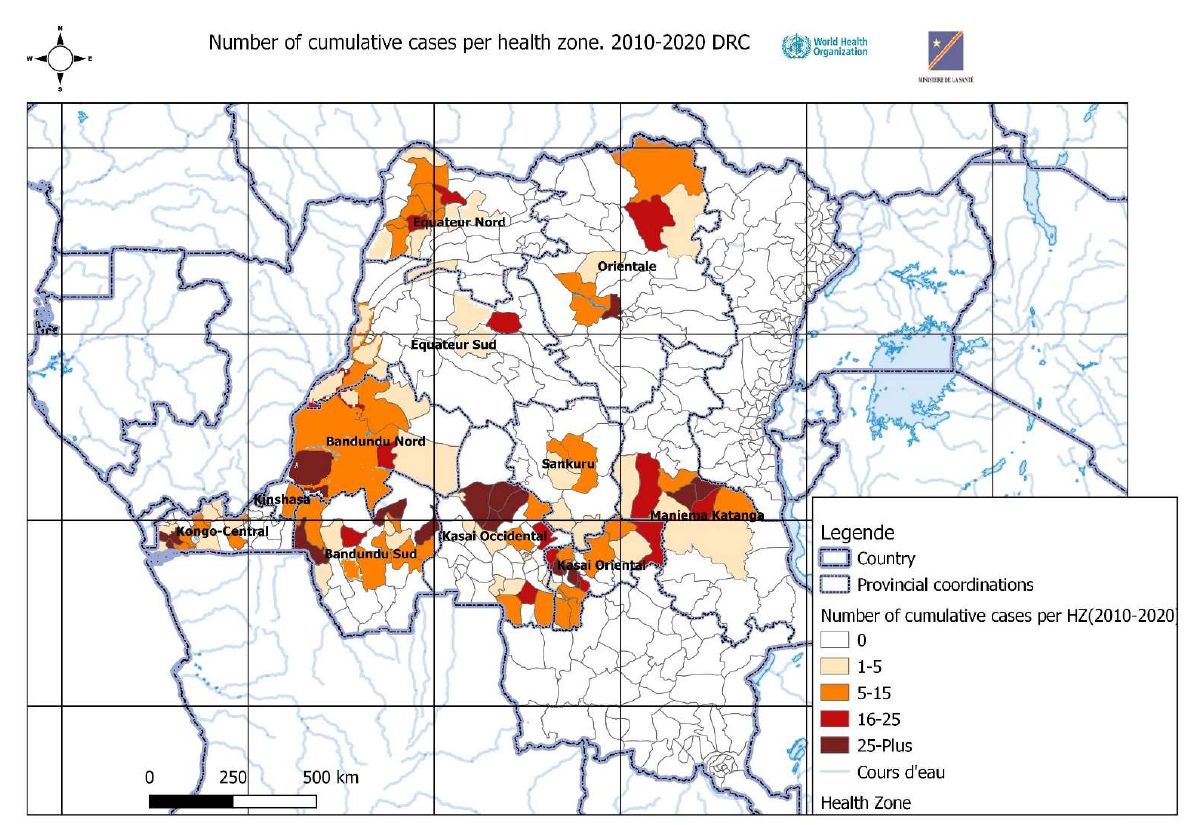
Figure 1. Map of HAT prevalence in the Democratic Republic of Congo. (Source = PNLTHA DRC). HAT control includes three key strategies: screening of people living in endemic areas, treatment of infected people to eliminate the human reservoir, and the reduction of human–tsetse fly contact through vector control activities [4,5]. Screening for HAT is done actively or passively. Active screening includes mass campaigns organized by mobile teams aimed at all people living in targeted endemic areas. Passive screening happens at health centers or hospitals when infected people seek health care. Treatment of HAT is offered free of charge to those who have been infected [6,7]. 1.2. Local Communities’ Knowledge of and Behaviors towards HAT In DRC, local communities living in endemic areas have a good understanding of HAT, including the vector and the symptoms (especially for the second phase). They also have good information about control measures: diagnosis, treatment, and vector control [8]. In DRC, most community members in endemic areas are knowledgeable about screening processes, especially lumbar puncture and its side effects [8]. When it comes to treatment, people living in endemic areas know that sleeping sickness can only be treated by specialized health workers [8]. People from the community can tell the difference between Arsobal (the old treatment) and NECT (the newer treatment) [9]. In relation to vector control, local communities are familiar with the main strategies: tsetse traps and clearing their surroundings, which contribute to reducing tsetse fly–human contact [10]. This local community knowledge of HAT has also been found in studies conducted in other endemic countries such as South Sudan [11], Uganda, and Kenya [12]. However, in DRC, as in other African countries, beliefs linking HAT (especially the symptoms of the